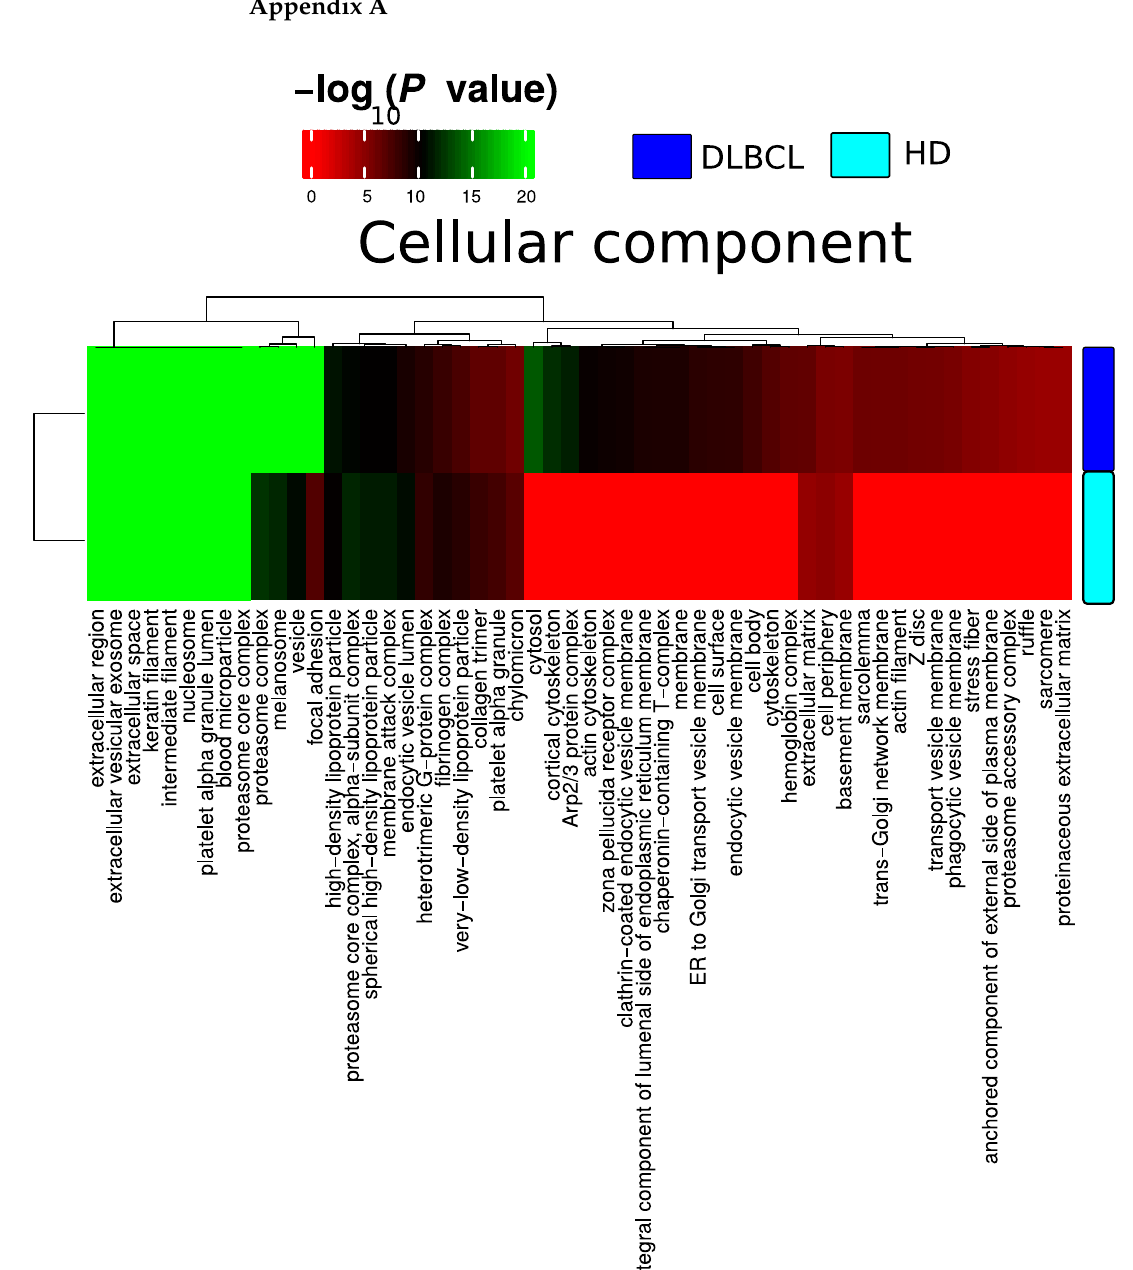
Figure A1. Summary of functional categories that are either enriched in HD or DLBCL based on functional enrichment in all identified protein from DLBCL and HD when compared with the cellular component.